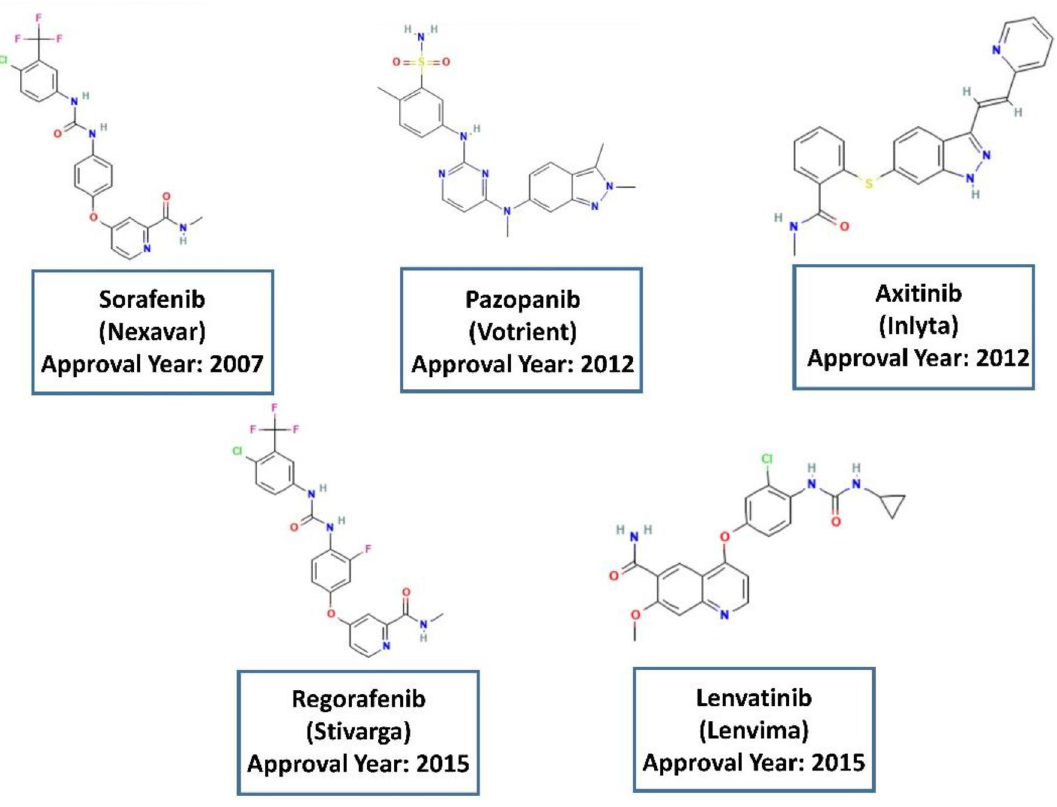
Figure 1. Some of the clinically approved VEGFR2-kinase